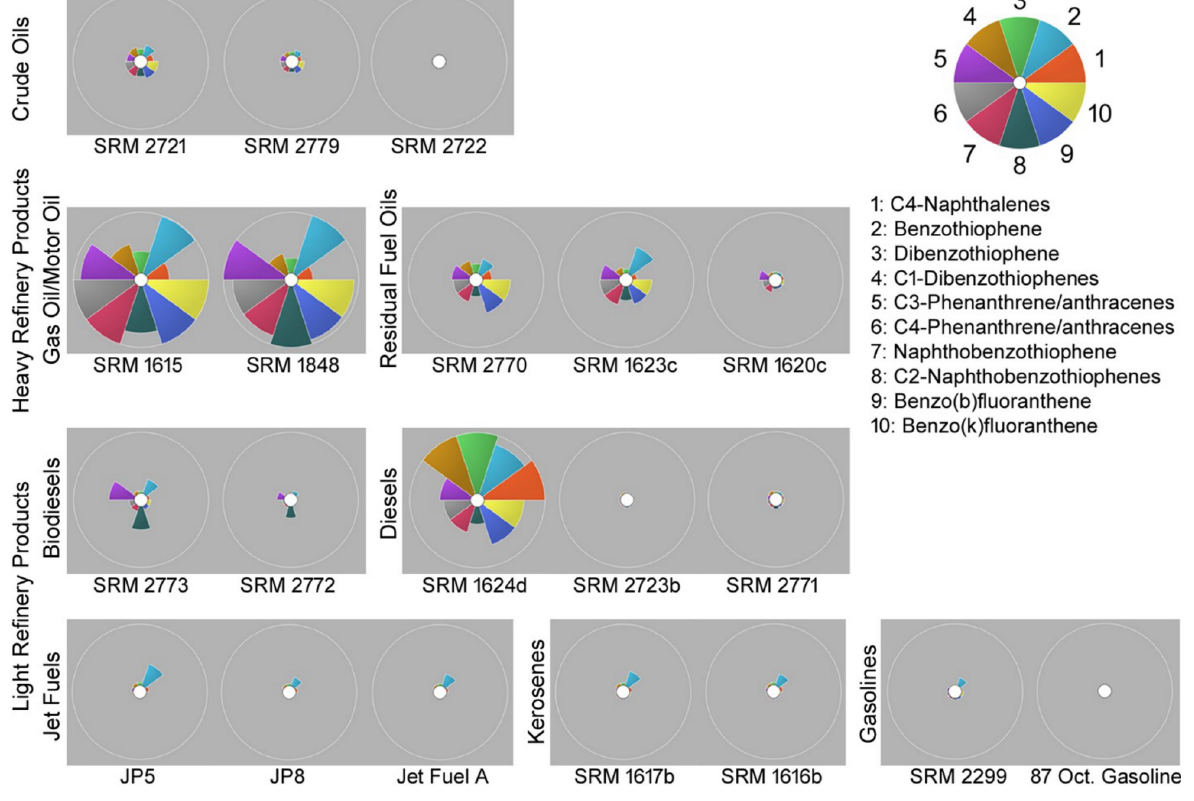
Fig 7. ToxPi visualization of SRM samples using top 10 most informative chromatographic